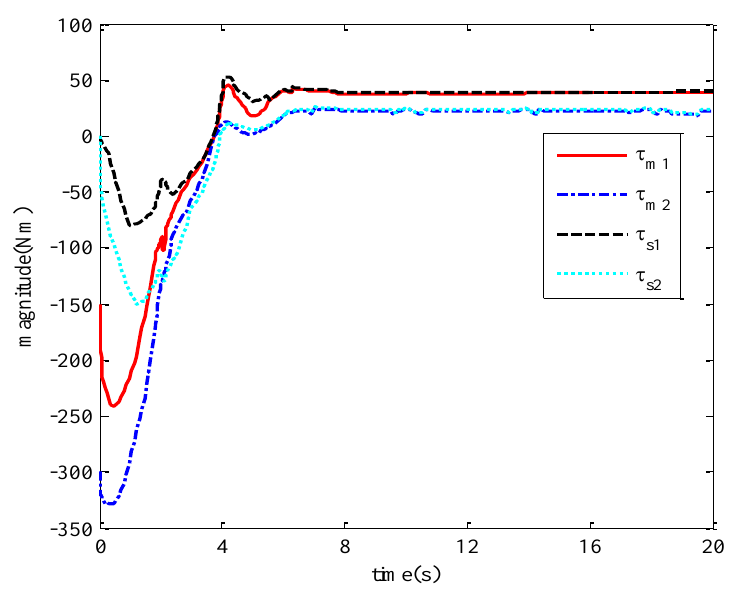
Figure 6. Input torque of master – slave robot joint.